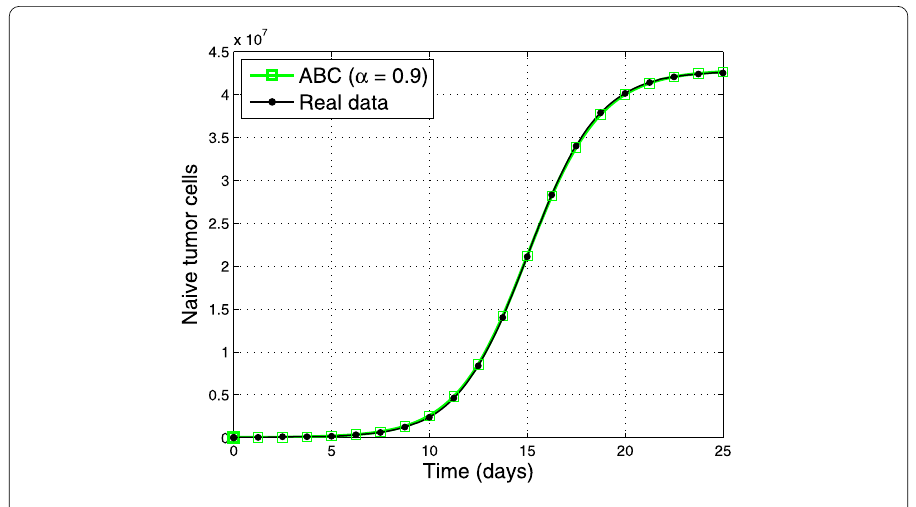
Figure 3 The growth of naive tumour cell population derived by the ABC fractional model with α = 0.9 [29] versus the real data of tumour growth used in [49]